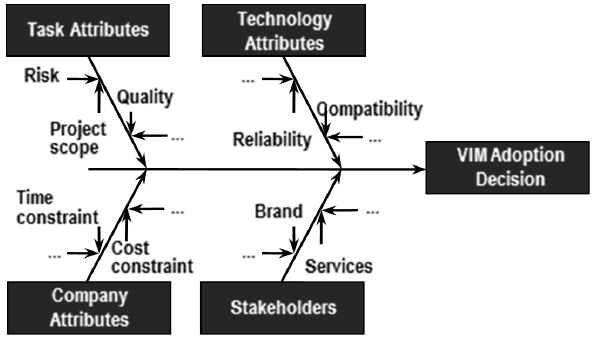
Figure 2. Fishbone framework of the influential factors in Virtual Information Modeling (VIM) adoption decision.